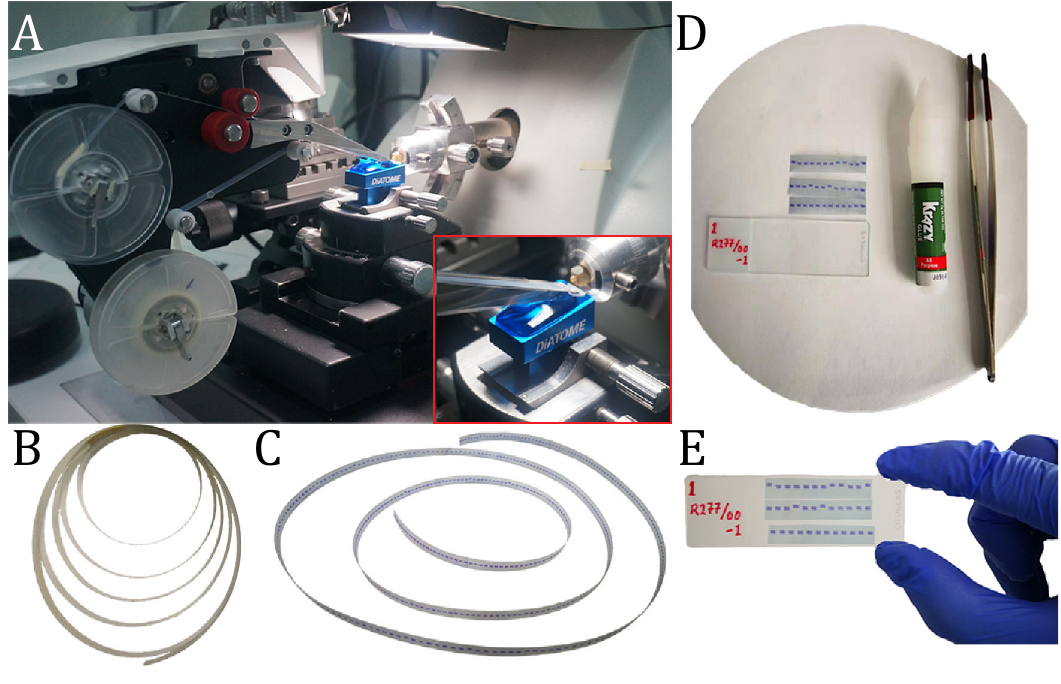
Fig. 2 Image of the AutoCUTS-LM and sample preparation on tape. A The supply-reel of the AutoCUTS-LM contains a transparent plastic tape that collects sections from the knife boat to the fi nal take-up reel. (Red frame) Close-up view of the tape conveyor belt positioned in front of the knife boat with the mounted sample. B Collected sections on the transparent tape before staining. C Sections have been stained with toluidine blue. D Setup to glue the sections on the microscopic glass slide. E Stained sections glued on a microscopic slide and ready for image